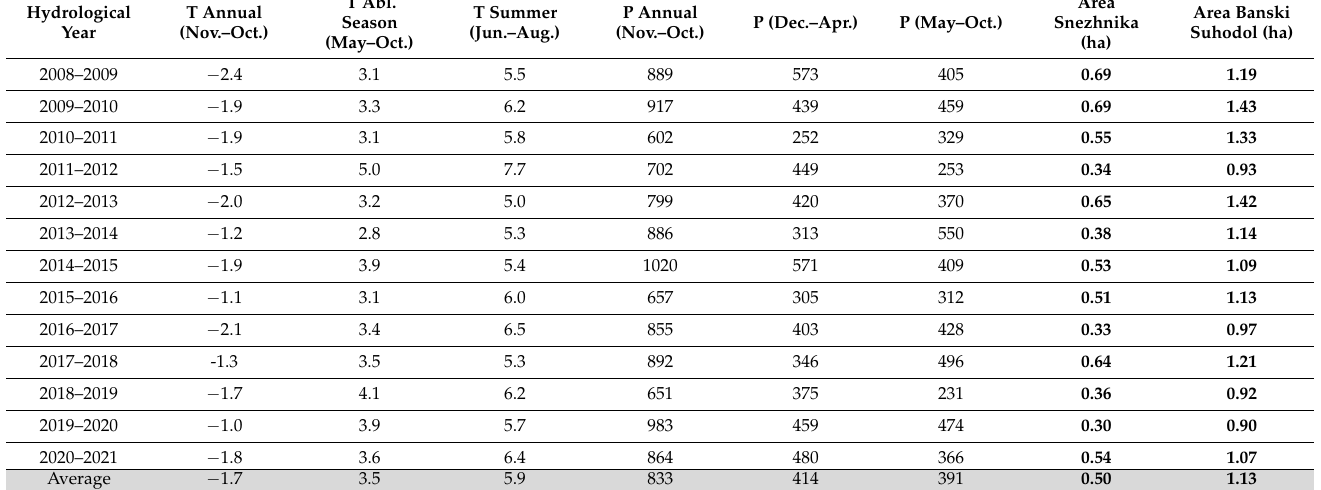
Table 1. Climatic data for the Musala peak weather station (data from [32]), summarized for glacieret hydrological years 2008/2009 to 2020/2021 (T—temperature,